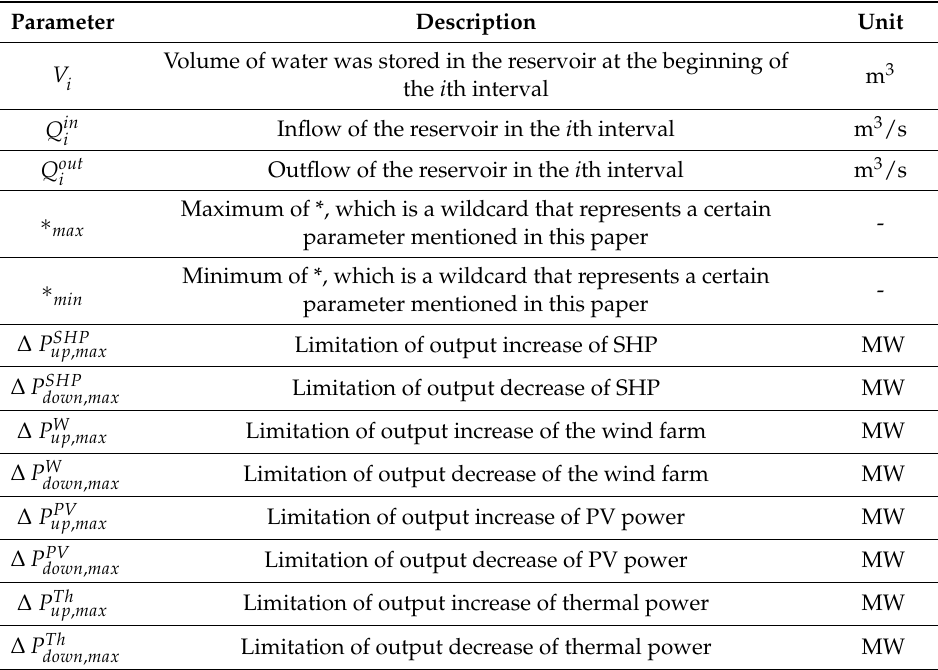
Table A6. Parameters of constraints of the power